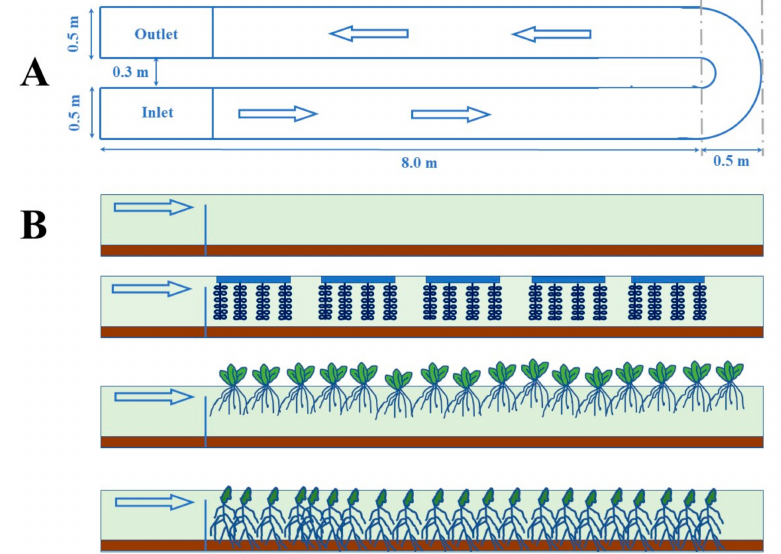
Figure 1. Schematic diagrams of the laboratory-scale surface flow constructed wetlands (LSCW). Planform ( A ) and lateral views ( B ) of the LSCW are demonstrated, and the arrow points in the flow direction. The treatments are shown from top to bottom in ( B ) as the control (CK), treatment with polyethylene fibers (PFT), with E . crassipes (ECT), and with M . aquaticum (MAT),